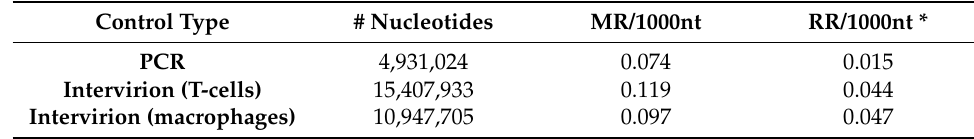
Figure 1. Experimental system and potential sources of error. Experimentally ‐ induced recombination or mutation may arise at any point from plasmid production to sequencing. To control for this and to assess the contribution of different stages of processing to the observed rates, we analysed a variety of controls. All controls included underlying sequencing error, and in addition ( A ) DNA PCR control measures PCR induced recombination and mutation ( B ) Intervirion control measures PCR and homozygous infection induced recombination, and total mutation mutation rate due to transfection, infection and sequencing. ( C ) Transfection induced recombination control measures mutation and recombination rates due to transfection of CEM cells, reverse transcription of virus and PCR amplification. ( D ) Our experimental samples—heterozygous infection—allows us estimate the rate of infection ‐ associated mutation and recombination. Table 1. Control results from experimental infections.